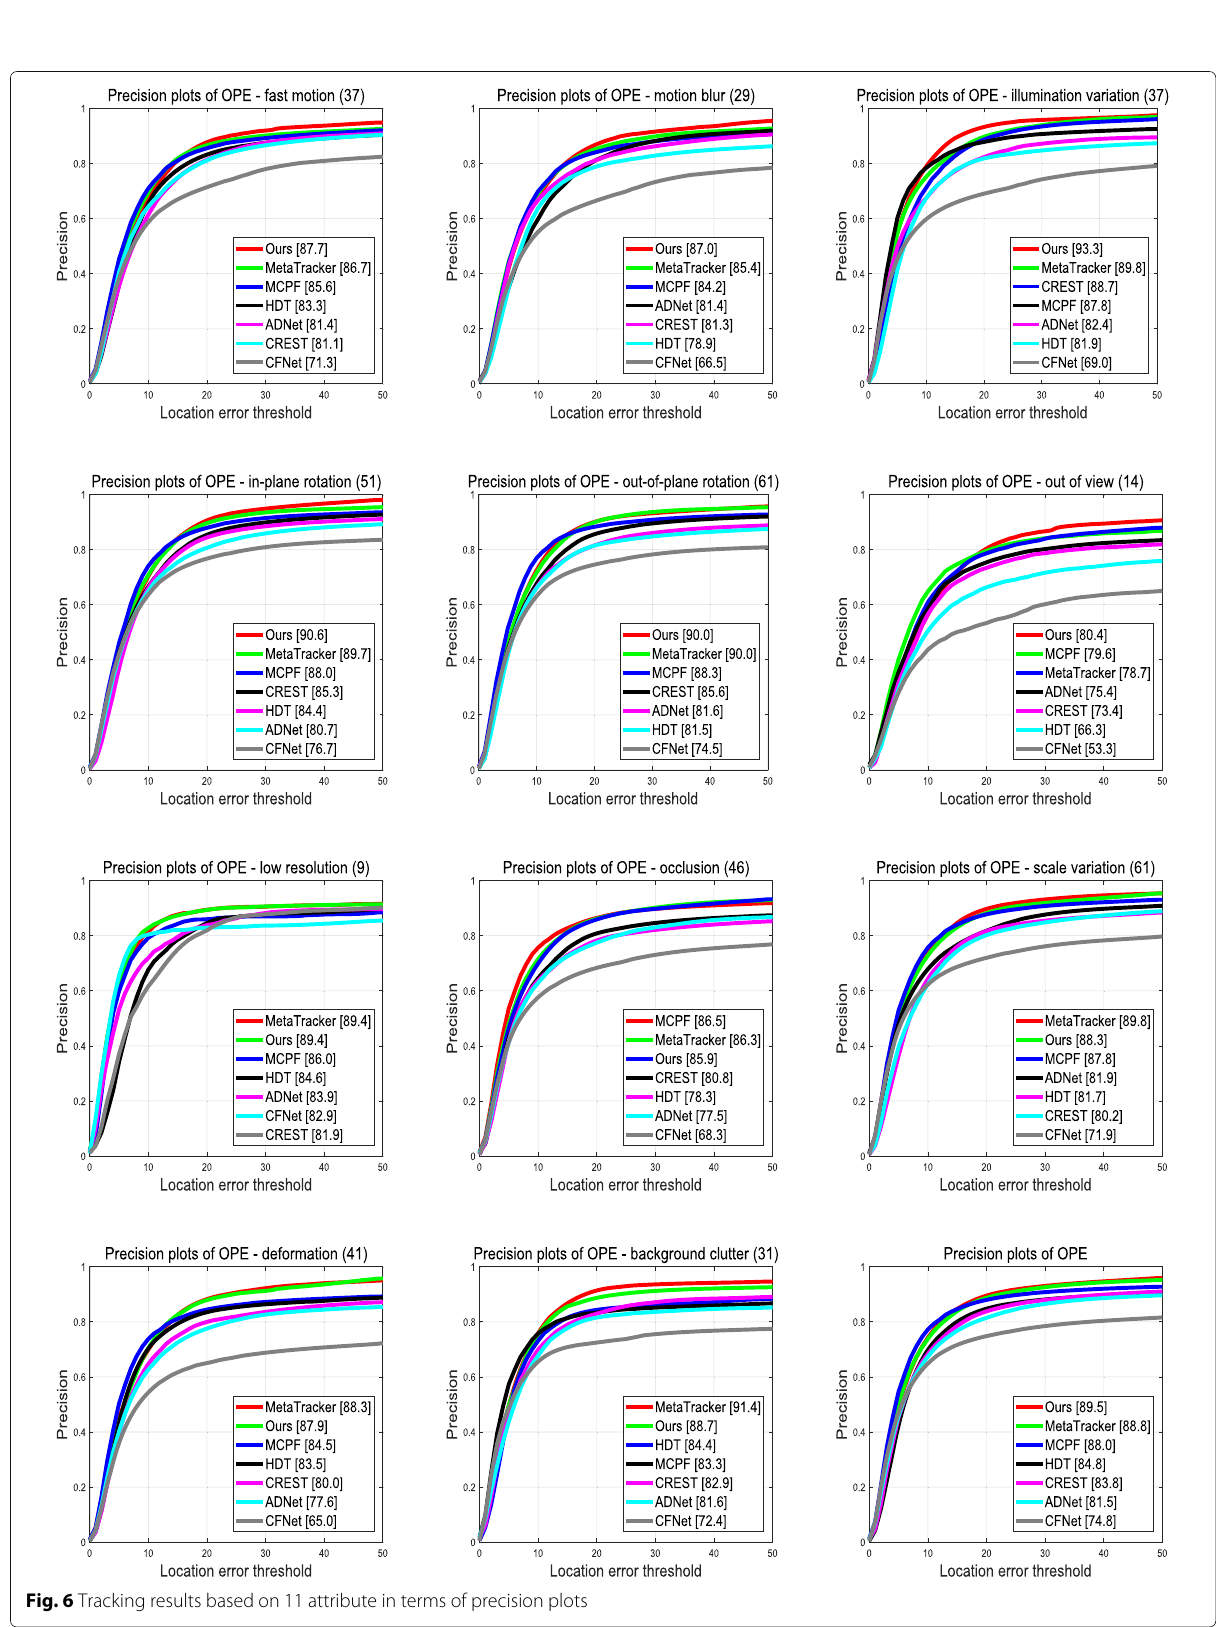
Fig. 6 Tracking results based on 11 attribute in terms of precision